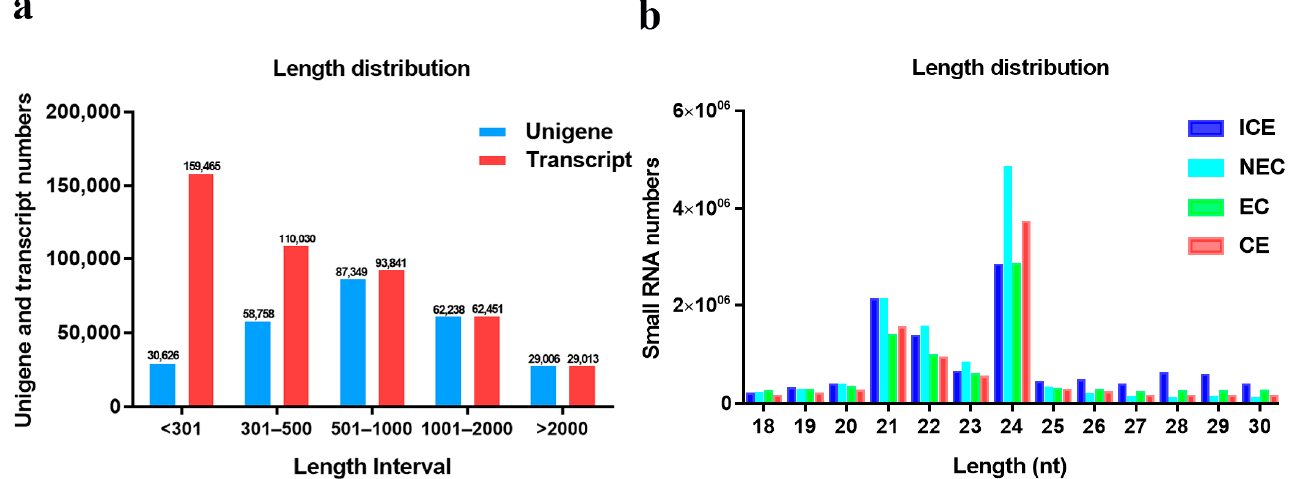
Figure 3. Unigene and small RNA length distributions. ( a ) Unigenes and transcriots; ( b ) Small RNAs. Table 1. Transcriptome data quality profile.